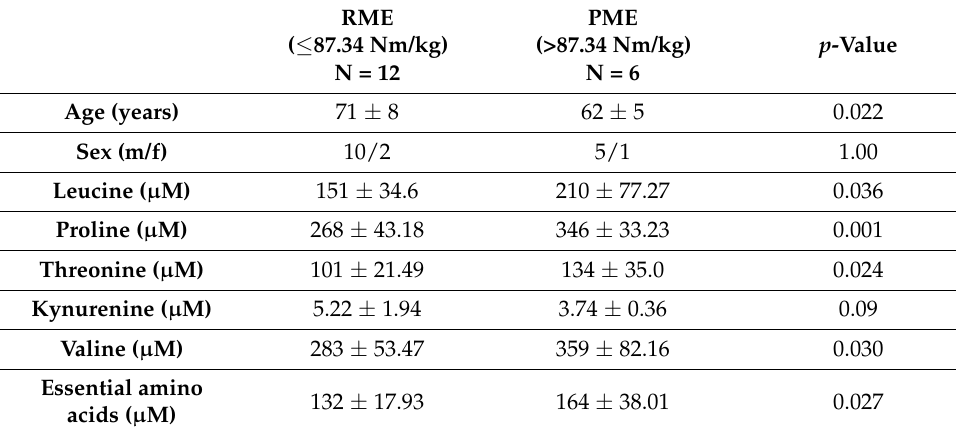
Table 4. Metabolomic profile of patients with HFrEF and RME vs.